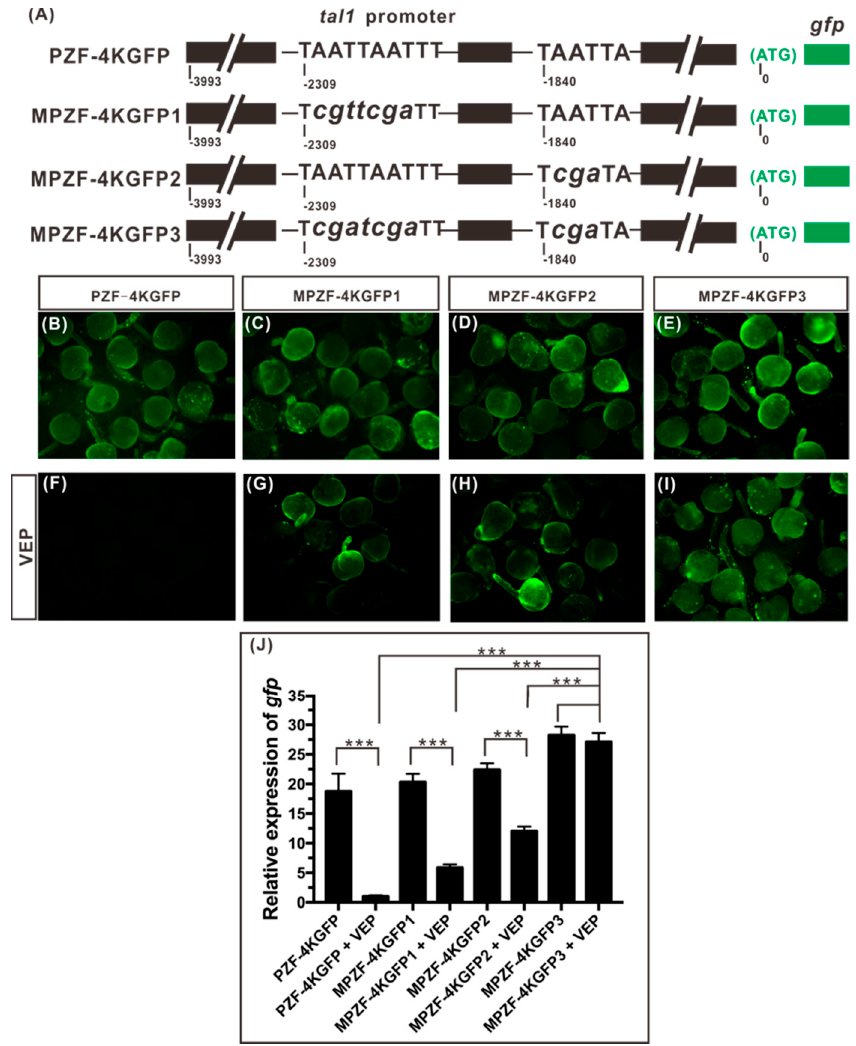
Figure 5. Both binding sites, 12 and 14, in tal1 proximal promoter are essential for Vsx1 to inhibit tal1 expression. ( A ) Diagram of GFP report sensors driven by wild-type or different mutant tal1 proximal promoter. Lower cases indicate the mutant bases at the binding sites 12 and 14. ( B–I ) VEP: vsx1 expression plasmid. GFP expression driven by wild-type or different mutant tal1 proximal promoter at 24 hpf. The types of GFP reporter sensors are shown at the tops of the images, and the co-injected vsx1 expression plasmid is shown on the left of the images. ( J ) Quantitative analysis of Vsx1-dependent tal1 repression mediated by different mutant tal1 proximal promoters. Results are expressed as means ± SEMs, and statistical analyses were done by unpaired t-test. *** indicating statistically significant difference ( p < 0.001).